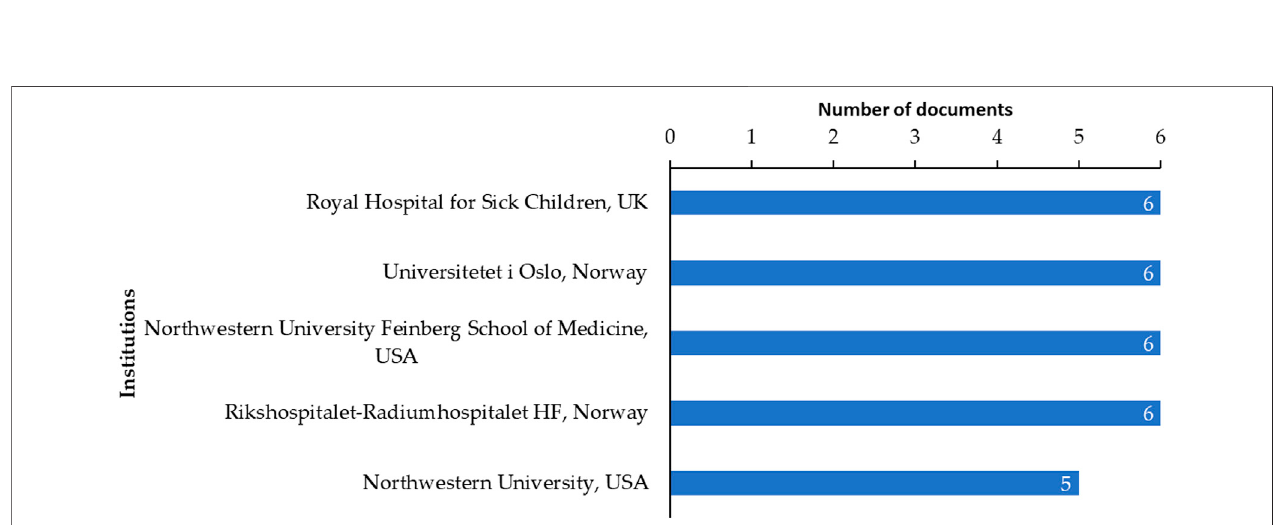
FIGURE 6 | Top 5 institutions contributing to the fi eld of radiotherapy and male reproductive research.